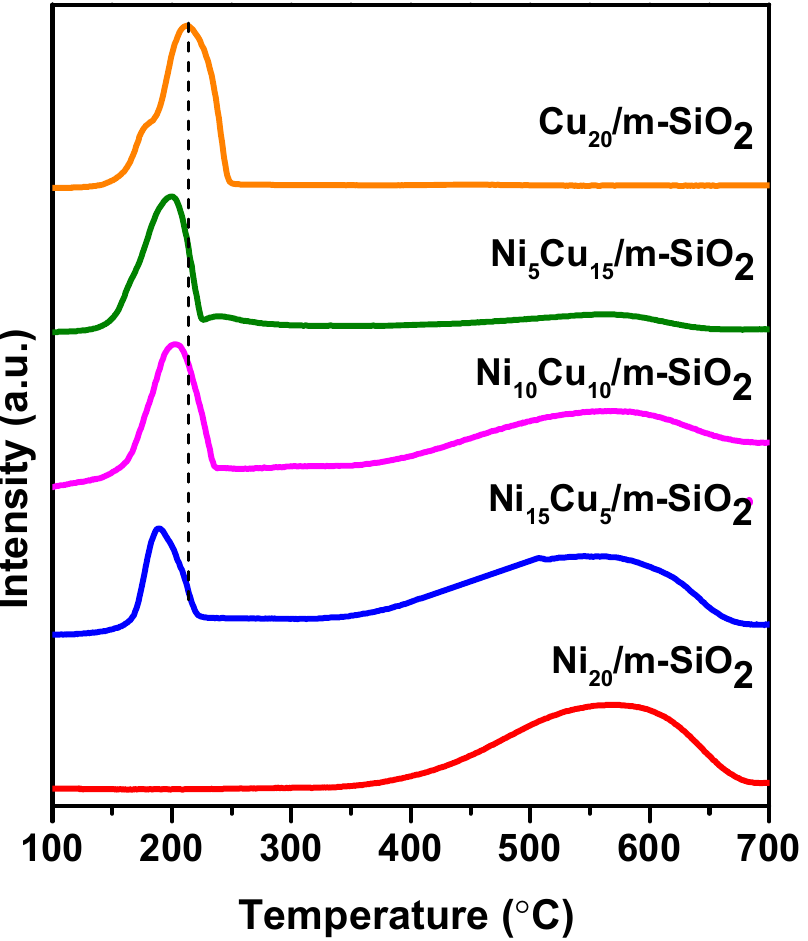
Figure 5. H 2 -TPR profiles of Ni x Cu y /m-SiO 2 catalysts.